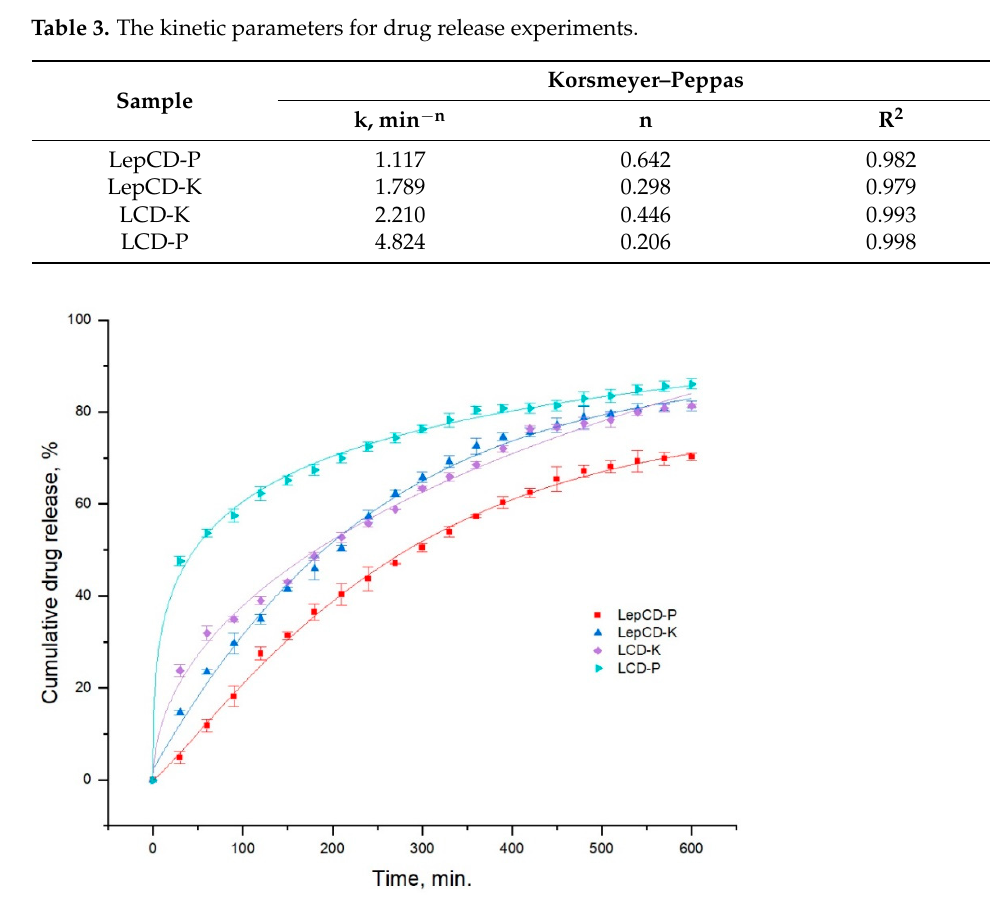
Figure 4. Cumulative drugs release for the tested materials.